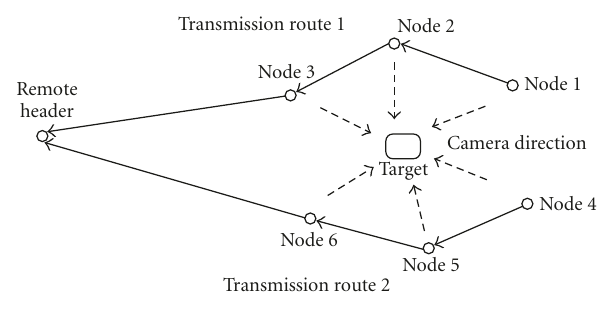
Figure 1: Diagram of sensor